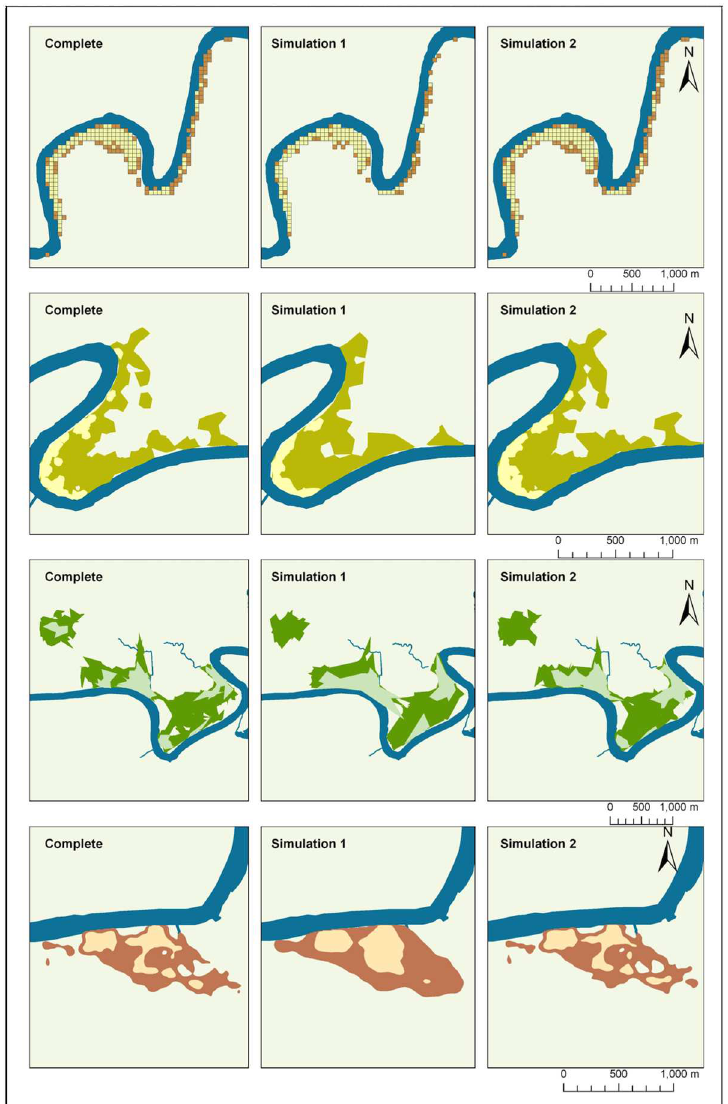
Fig 6. An example of selected home range estimators under different simulations. (A) grid-cell method (GCM), (B) adaptivelocal convex hull ( a -LoCoH), (C) adaptive time local convex hull (T-LoCoH), and (D) biasedrandom bridges (BRB). Simulation1 simulatedlow fix rate (every 4 hours) and Simulation2 simulated fix failures (light = 50% isopleth, and dark = 90% isopleth).